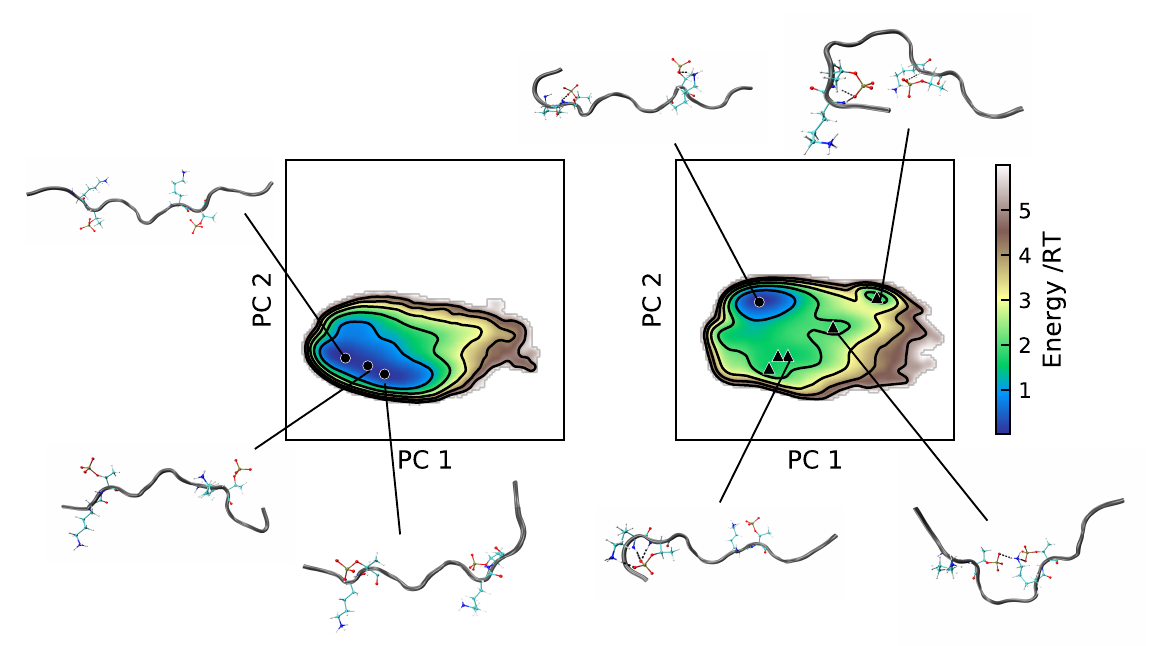
Figure 5. Energy landscapes and conformations in selected minima of Tau1. ( Left ) A99; ( right ) C36. The energy landscapes are constructed using the first two components from principal component analysis, using the same basis set for both force fields, such that they are directly comparable. Contour lines are drawn for integer energy levels in the interval 1 ≤ RT ≤ 5, and the minimum of each basin is represented by a marker: (cid:108) : energy ≤ 1 RT , (cid:115) : ≤ 2 RT . In the conformations, the phosphorylated and positively charged residues are shown explicitly. Dashed black lines represent hydrogen bonds. The peptide conformations are color-coded according to the secondary structure determination in VMD, where silver is irregular (coil) and cyan is turns. The N-terminus of each conformation is the leftmost